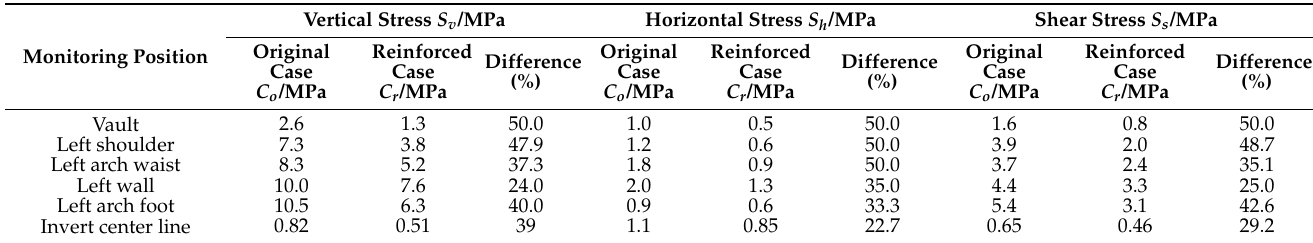
Table 3. Comparison of surrounding rock stress before and after reinforcement.